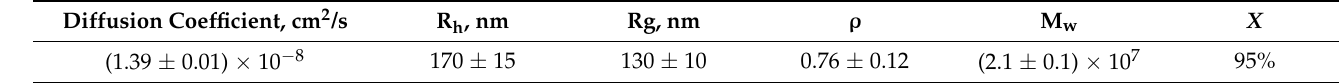
Table 1. Major characteristics of